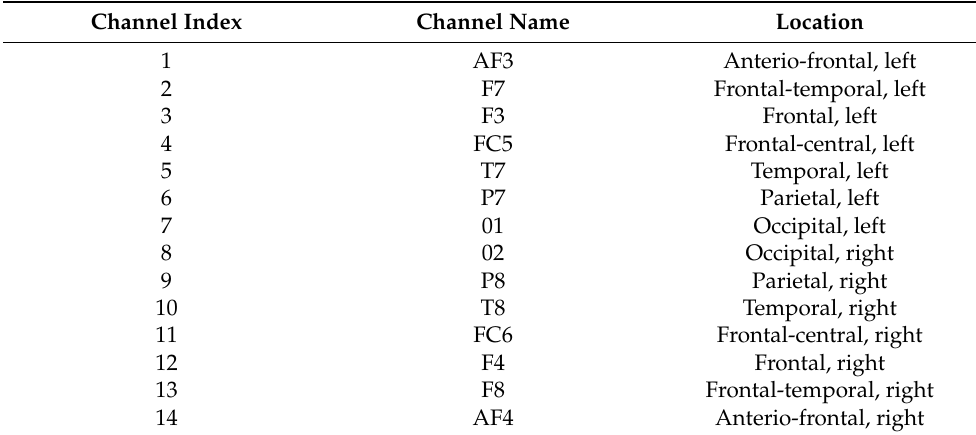
Figure 2. EEG recording electrode scalp locations in emotive EPOC system. Table 1. Channel index, name, and